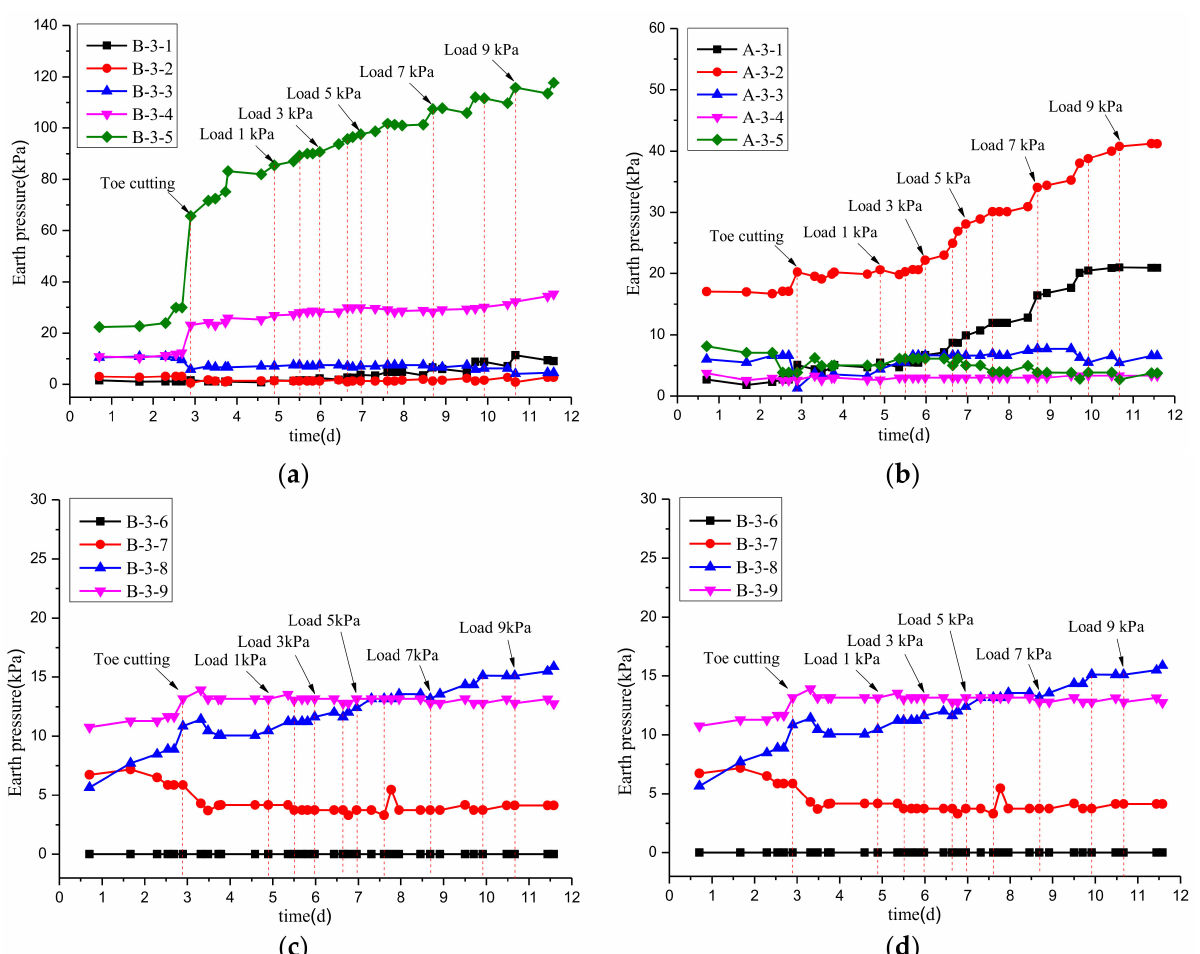
Figure 11. Earth pressure of pile no. 3: ( a ) curves of earth pressure before the anti-sliding segment of pile no. 3; ( b ) curves of earth pressure behind the anti-sliding segment of pile no. 3; ( c ) curves of earth pressure before the anchoring segment of pile no. 3; ( d ) curves of earth pressure behind the anchoring segment of pile no.